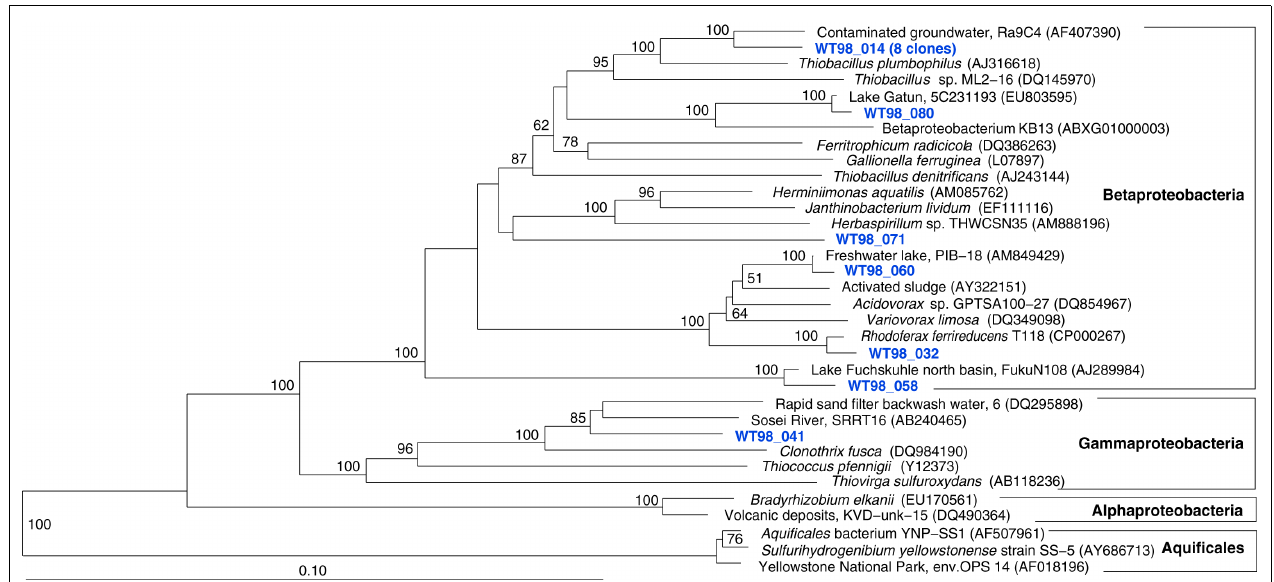
FIGURE 8 | Phylogeny ofWestThumb 98 proteobacterial clones, based on E. coli 16S rRNA gene nucleotide positions